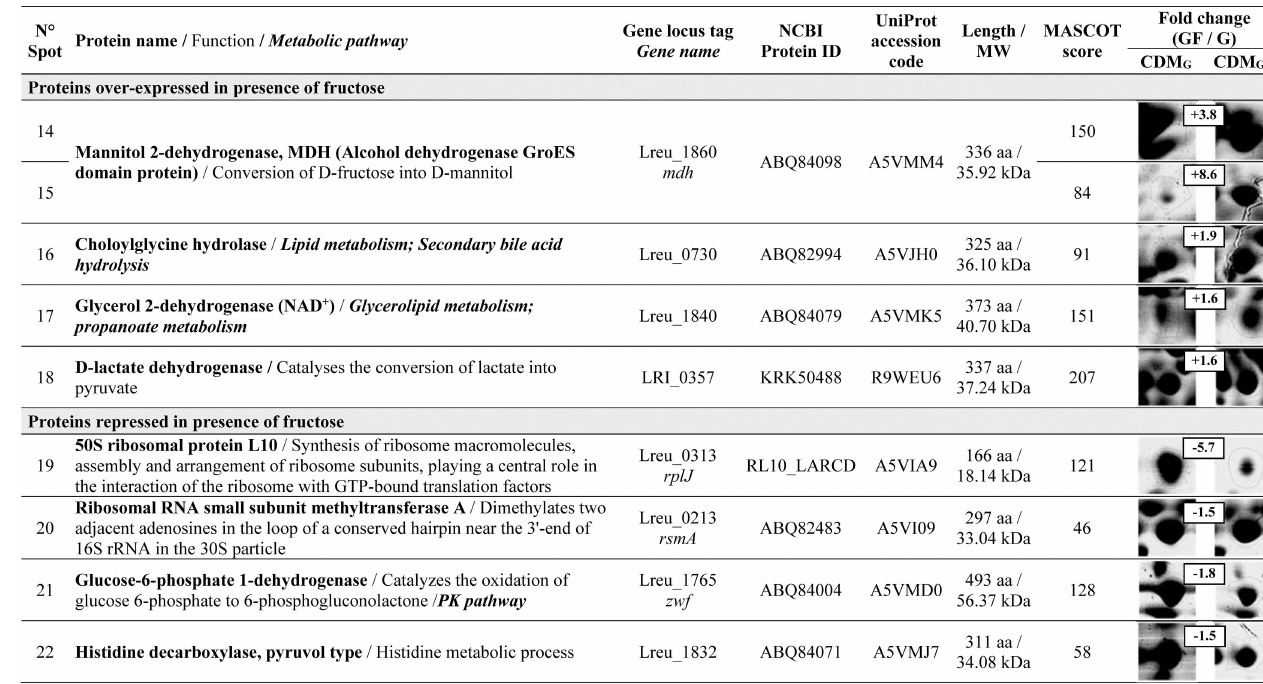
Fig 7. Proteins of Lactobacillus reuteri CRL 1101 over-expressed or repressedat 24 h of incubation in the presence of fructose, separated by 2DE and identified by